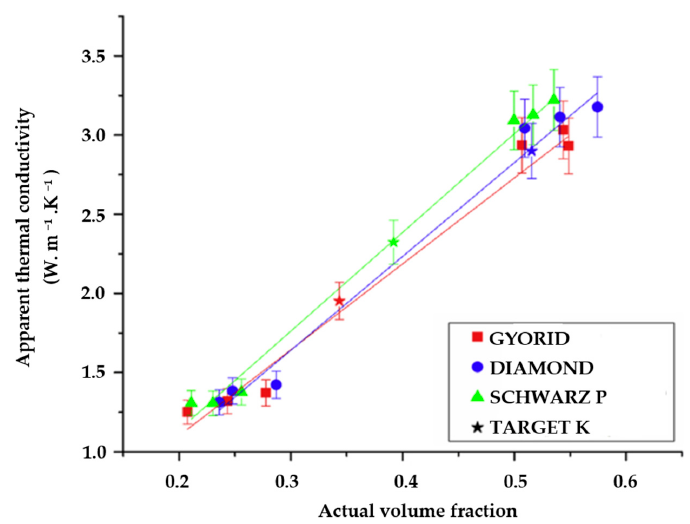
Figure 8. Apparent thermal conductivity against actual volume fraction [98].